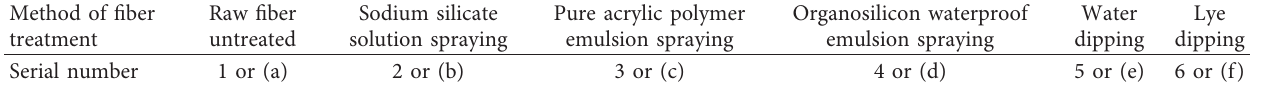
Table 3: The meanings of test serial number and test code.